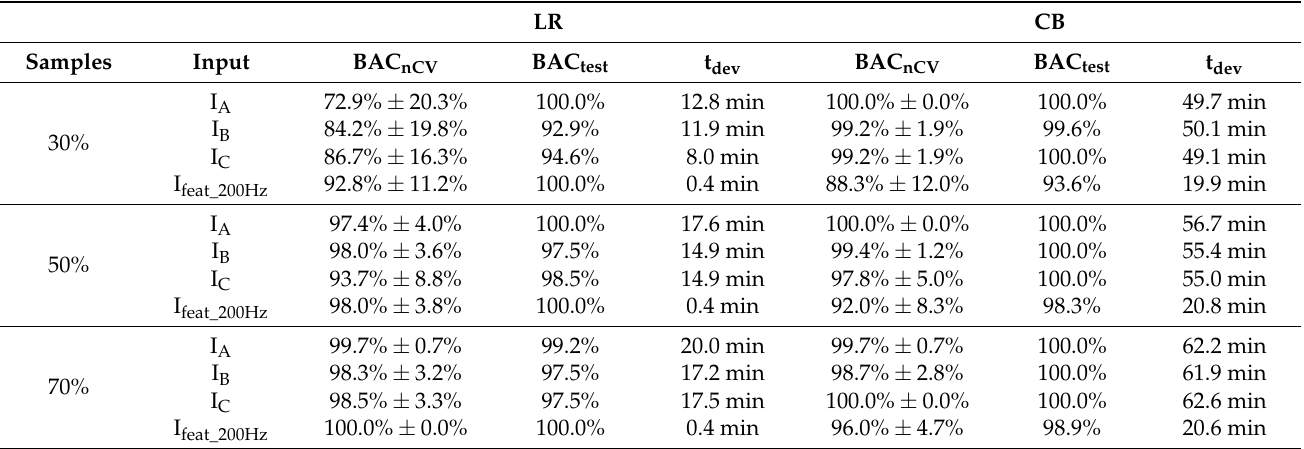
Table 4. The BAC of classifiers trained with FFTs of three phases of simulated current (I A , I B , and I C ) or features computed from the FFT data (I feat_200Hz ). The experiment was repeated with 30%, 50%, and 70% of samples in the training